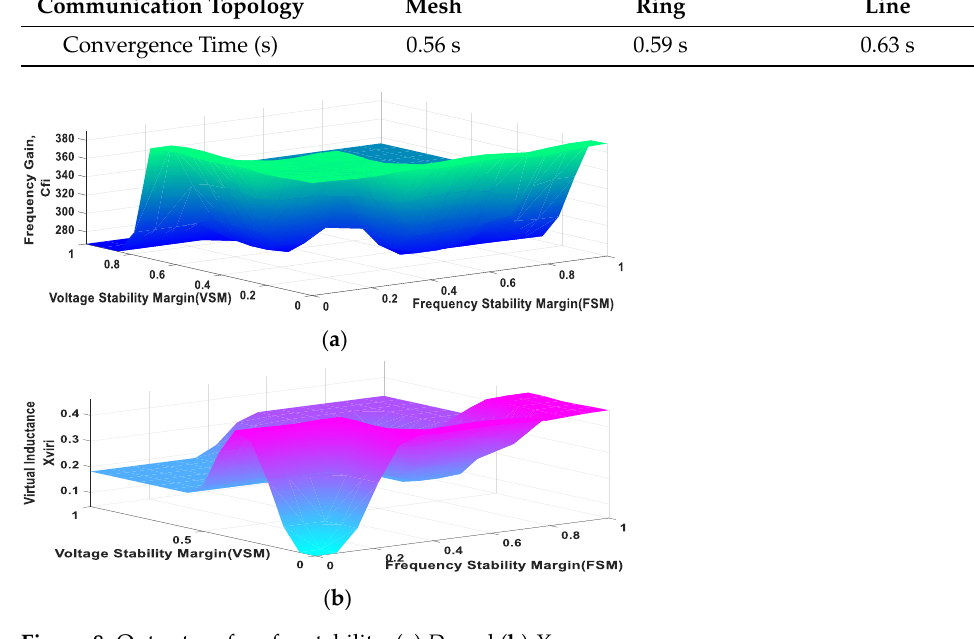
Figure 8. Output surface for stability. ( a ) D f and ( b ) X vir .